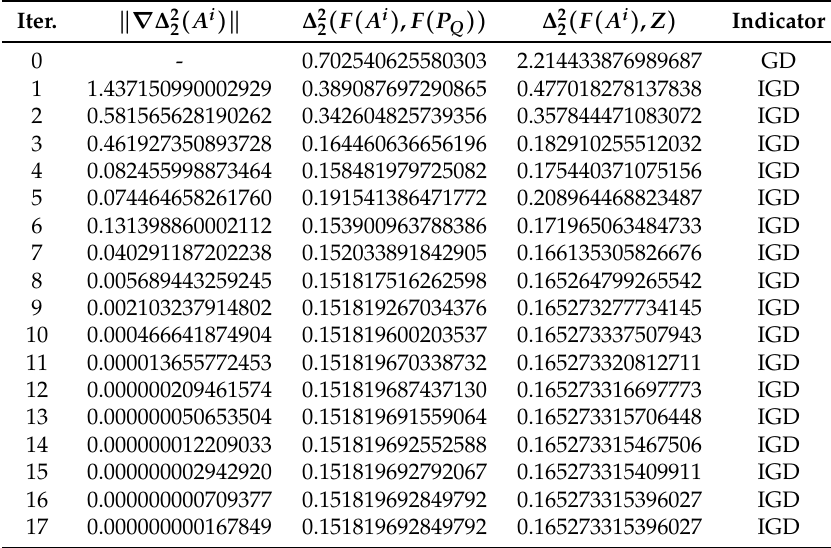
Table 12. Numerical results of the ∆ 2 bootstrapping method.